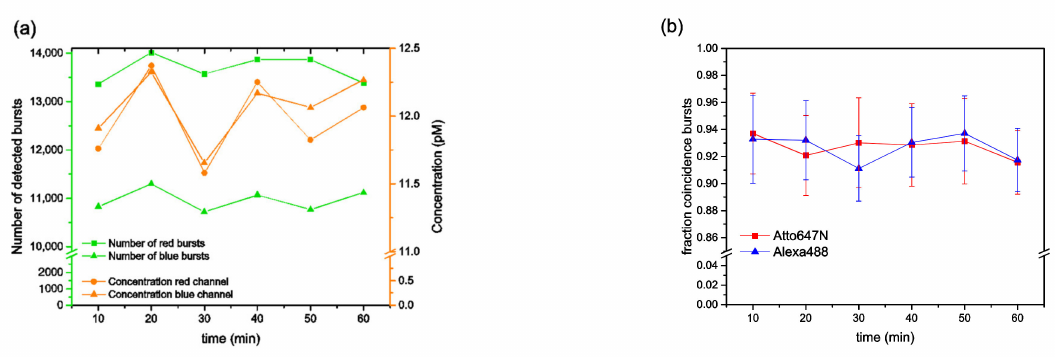
Figure 2. BTCCD results of double-labelled dsDNA samples. ( a , b ) For data which were obtained from measurements in buffers containing 0.005% Tween20, the same types of graphs are shown as in Figure 1b,c,